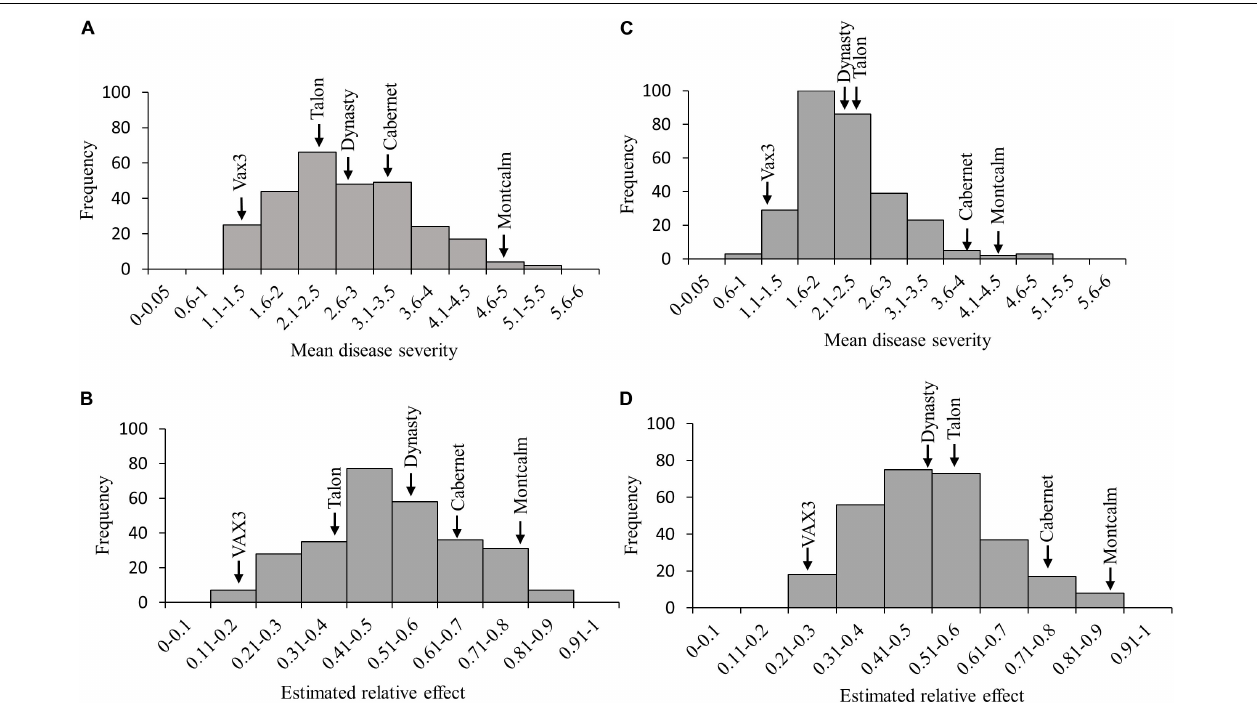
FIGURE 2 | Frequency distribution of (A) mean disease severity (MDS) and (B) the estimated relative effects of root rot caused by Fusarium solani in the Andean Diversity Panel (ADP). Frequency of (C) average disease score and (D) the estimated relative effects of Fusarium solani in the Middle American Diversity Panel (MDP). Arrows indicate the reactions of the five control